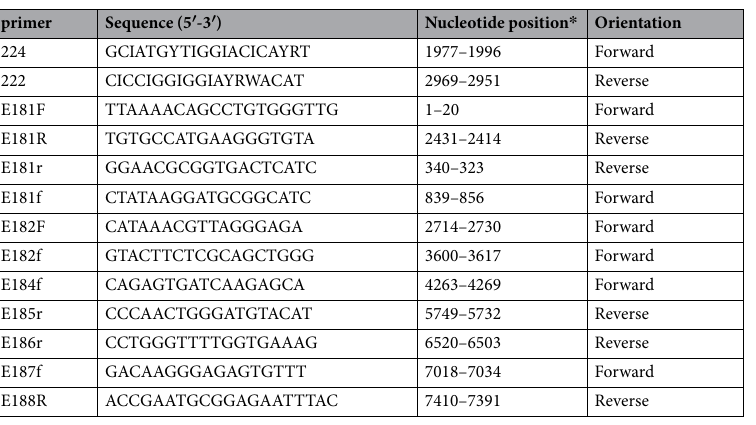
Table 3. Primers used for complete genome amplification and sequencing. * Numbering according to the genome of E-18 strain